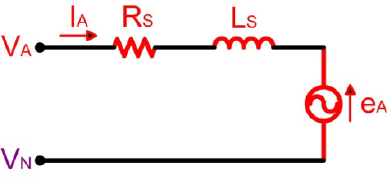
Figure 8 . Equivalent circuit of the BLDC motor for phase A